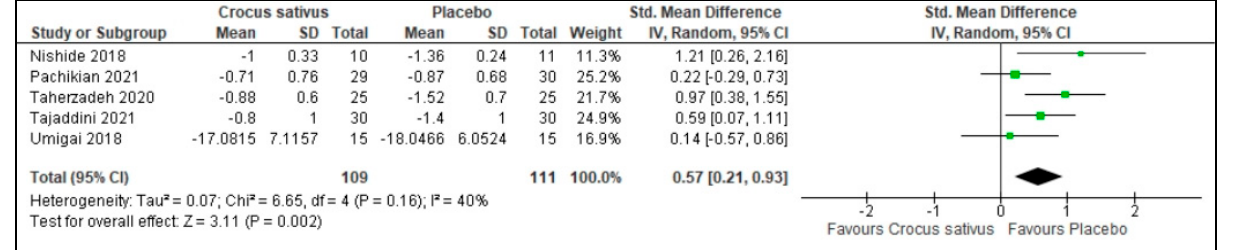
Figure 7. Forest plot for the outcome sleep duration [26,27,29–31]. Note: Line indicates confidence interval and the green square indicates effect estimate. Black diamond indicates cumulative effect estimate and its confidence interval.